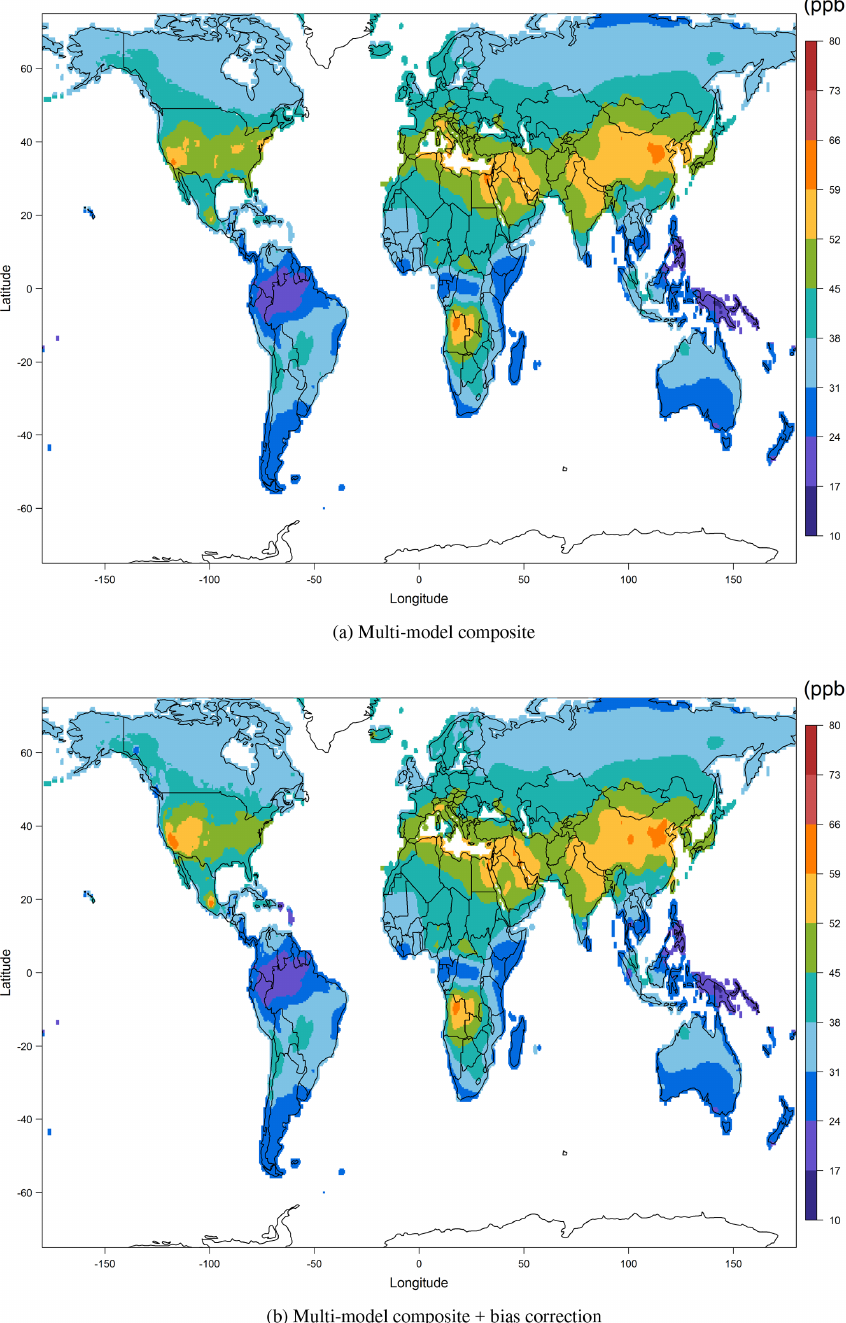
Figure 7. Multi-model composite and bias-corrected